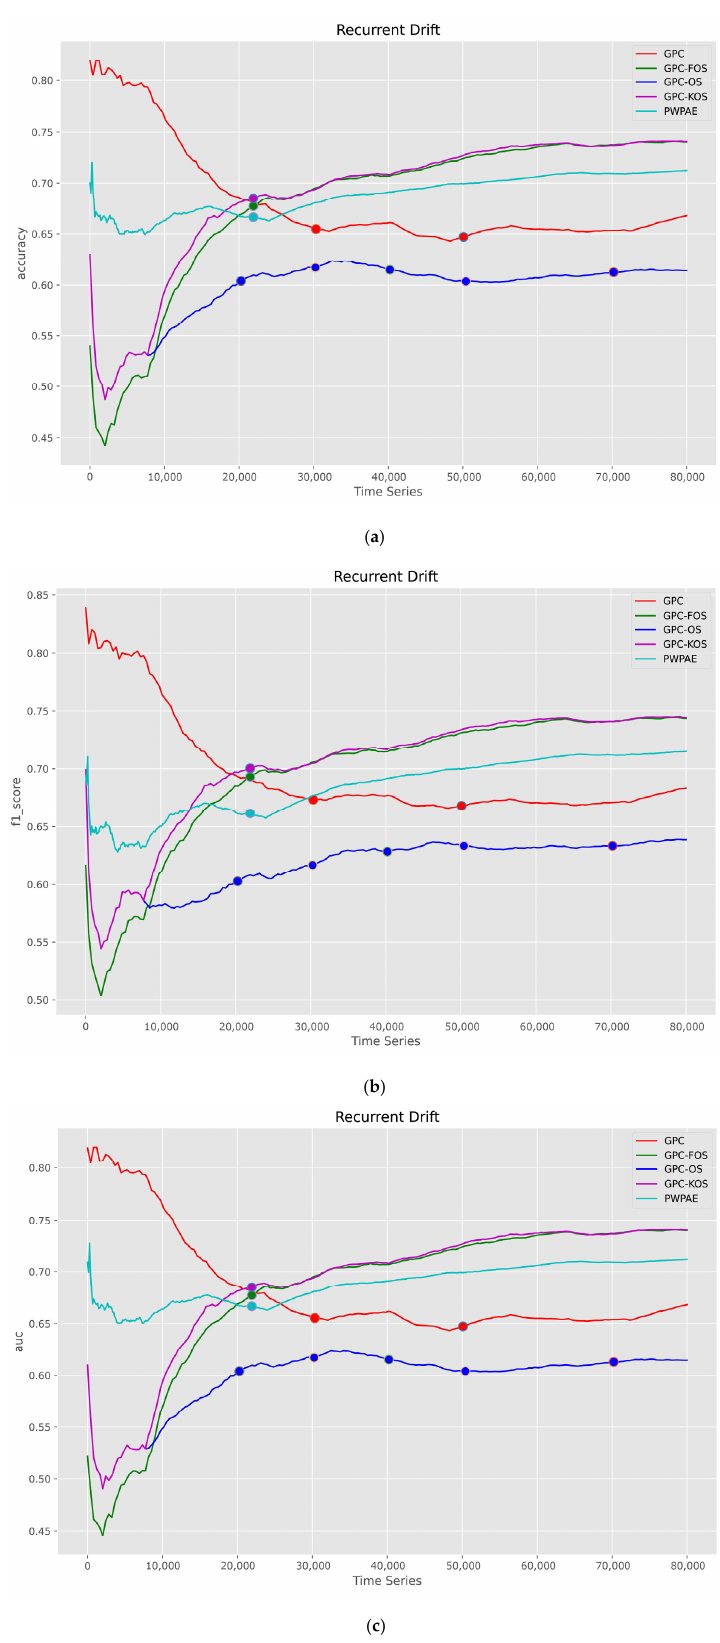
Figure 10. Visualisation of classi fi cation metrics as time series for a recurrent type of drift—( a ) accuracy, ( b ) F1-score, ( c ) AUC. The time series of the performance metrics for incremental drift are presented in Fig- ure 11. The results showed that GPC-FOS achieved the highest values for accuracy, F1- score, and AUC with a value of 0.73 for each.